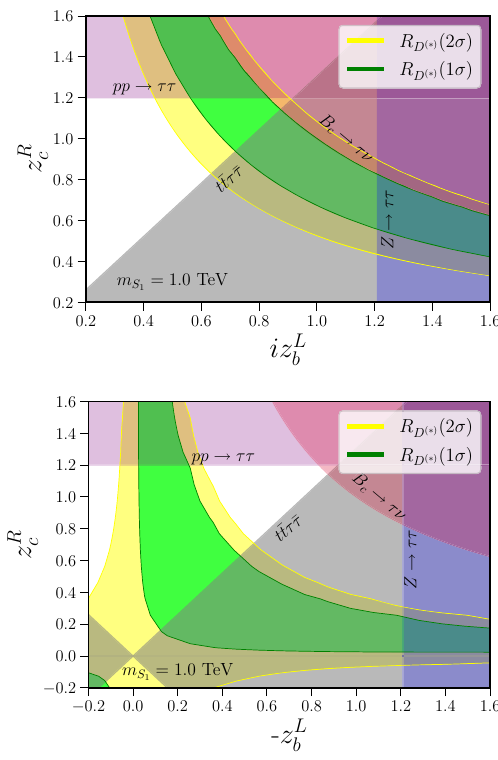
Fig. 2 1 σ (green) and 2 σ (yellow) allowed range for R D ( ∗ ) in the rel- evant Yukawa coupling plane, with the S 1 LQ mass fixed at 1 . 0TeV ∈ i (cid:12) (top) and C τ = − 4 C τ ∈ (cid:12) (bot- for the case with C τ s = − 4 C τ s T T tom). The vertical blue band corresponds to the Z → ττ constraint. The gray and purple band represent exclusions from LQ pair produc- tion in pp → t ¯ t τ ¯ τ [101] and from the most recent LHC searches in √ s = 13TeV with 140fb − 1 [82,83], the high- p T bins of pp → ττ at respectively. The red curved band corresponds to the exclusion from B c → τν τ decay with the conservative limit on branching ratio < 30% [96]